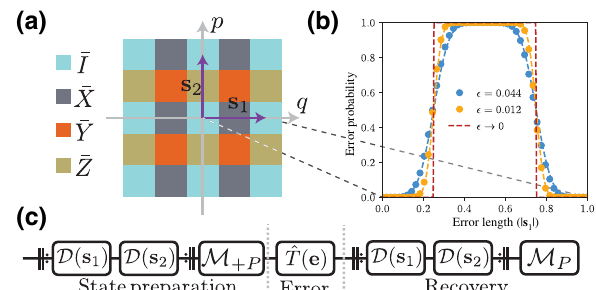
FIG. 4. Effect of translation errors in the square code. (a) Final Pauli error (colors) for different initial translation error e = ( q , p ) according to the classical model. (b) Logical error probability for translation errors of the form e = η s 1 . We compare the classical model Eq. (68) (dashed lines) and the full quantum model (dots), computed using the circuit in (c). We also compare different GKP size (colors), and in the infinite size limit (cid:21) → 0 we expect a sharp transition from correctable to uncorrectable error at e = s 1 / 4 and e = 3 s 1 / 4 (red dashed